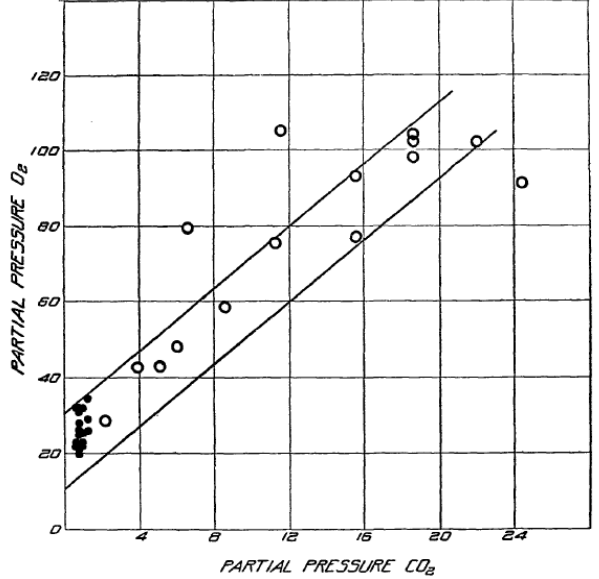
Fig. 2. From Redfield and Goodkind (1929). Partial pressures of Figure 2. From Redfield and Goodkind (1929). Partial pressures of oxygen and oxygen and carbon dioxide (mm.Hg) lethal to the squid Loligo carbon dioxide (mm. Hg) lethal to the squid Loligo Pealei. They found that the pealei . They found that the better the animal was oxygenated, the better the animal was oxygenated, the better it was able to withstand elevated better it was able to withstand elevated CO 2 levels. It was concluded CO 2 levels. It was concluded that “ CO 2 exerts no toxic effect except through its influence on the oxygenation of the blood. ” Very similar conclusions are reached that “CO 2 exerts no toxic effect except through its influence on the today. Although it is recognized that there is a vast range of tolerance of deep- oxygenation of the blood.” Very similar conclusions are reached to- sea animals to hypoxia and hypercapnia the concept of the O 2 :CO 2 ratio very day. Although it is recognized that there is a vast range of tolerance likely has relevance for regional impacts today. of deep-sea animals to hypoxia and hypercapnia the concept of the O 2 :CO 2 ratio very likely has relevance for regional impacts